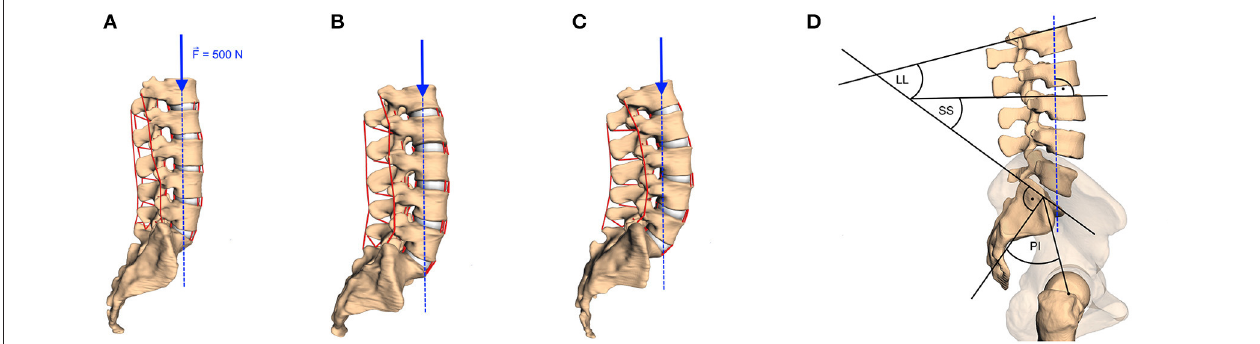
28 ◦ ), (B) regular (LL 49.2 ◦ ), and (C) hyperlordotic (LL 66.3 ◦ ). The method of calculating = = =